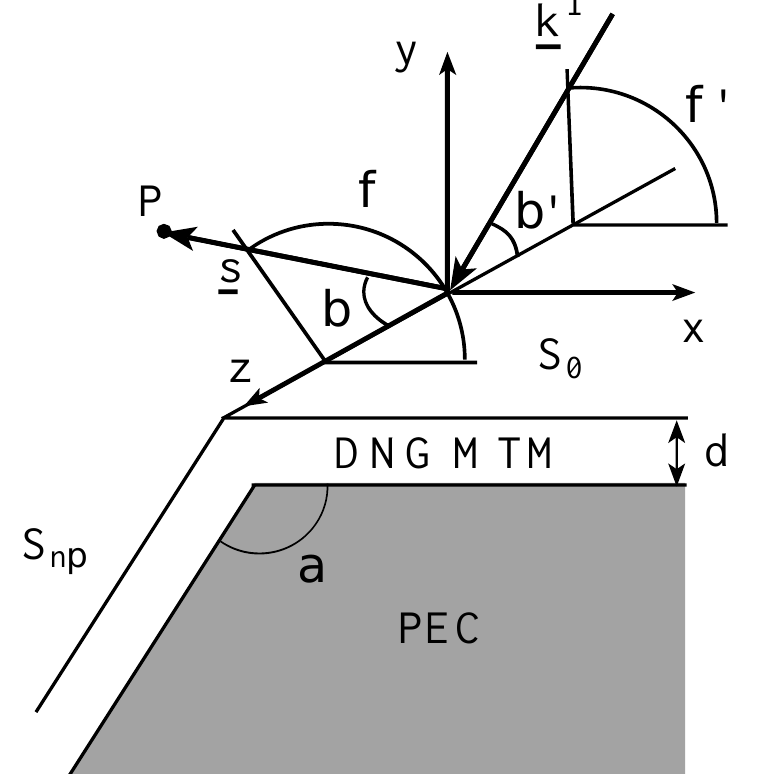
Figure 1. The diffraction problem.